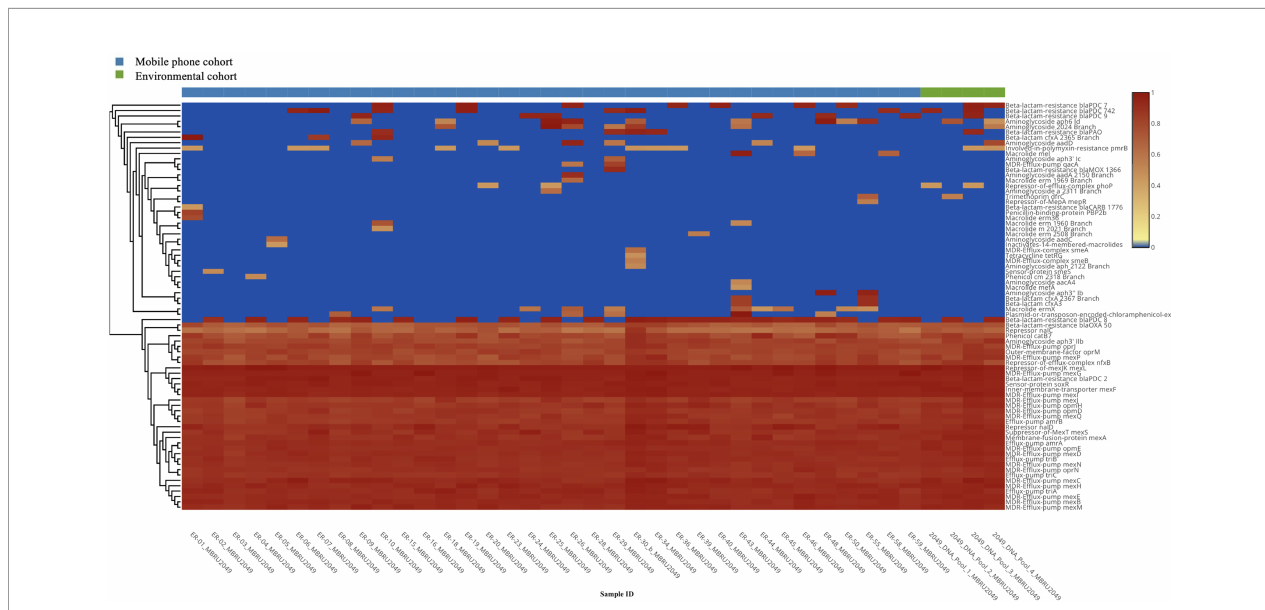
FIGURE 4 | Heatmap representation of the antibiotic resistance genes (ARGs) identi fi ed by metagenomic analysis of both mobile phone cohort ( n = 35 mobile phone swabs) and environmental cohort ( n = 4 environmental swabs, in green).